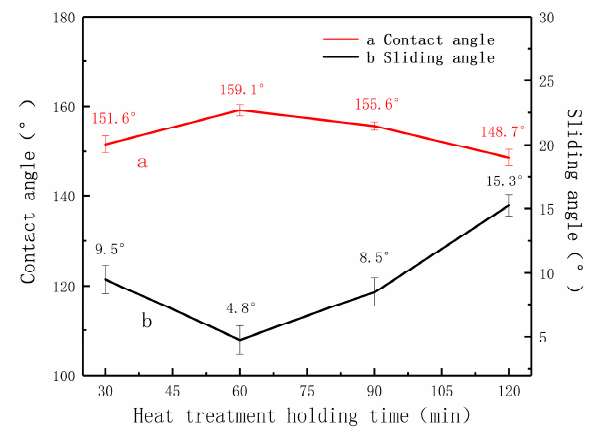
Figure 2. Contact angle of the samples with different heat holding time (385 °C): 30 min, 60 min, 90 min and 120 min.